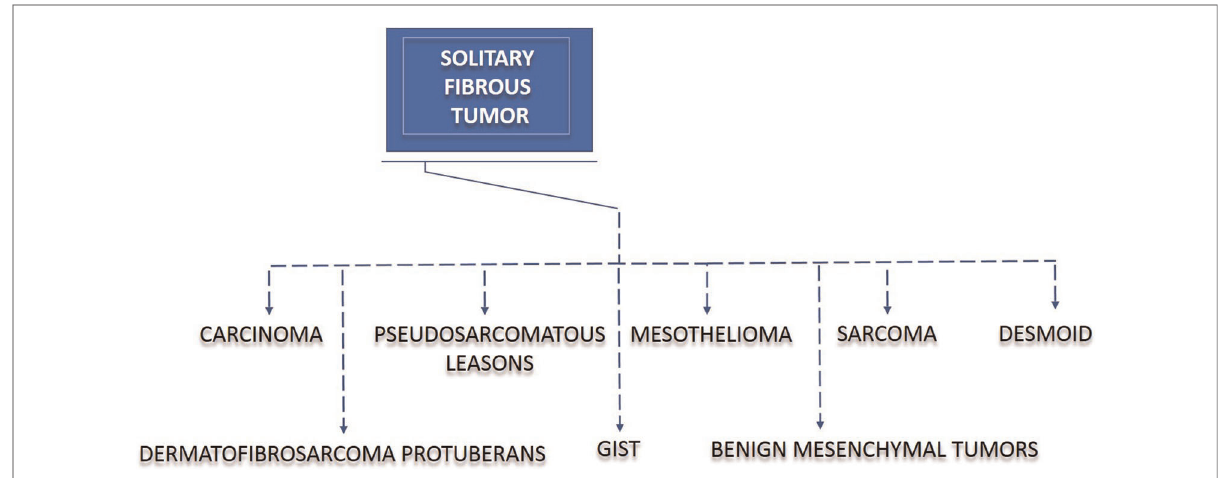
FIGURE 1 Solitary fi brous tumor (SFT) and disease overlap. SFT often causes dif fi culties in diagnosis and treatment. Due to a clinicopathological overlap, misinterpretation of other diseases may lead to incorrect diagnoses in patients with SFT. The diseases displaying the most similar patterns to SFT are sarcoma, gastrointestinal stromal tumor (GIST), mesothelioma, desmoid, benign mesenchymal tumor, dermato fi brosarcoma protuberans, carcinoma, and pseudosarcomatous